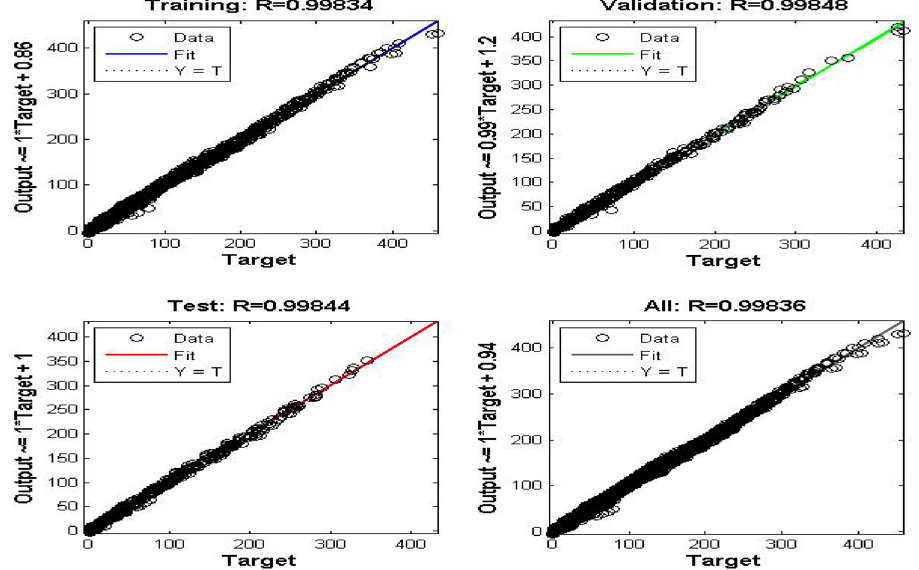
Fig. 3 Results of type-1 neural network using two hidden